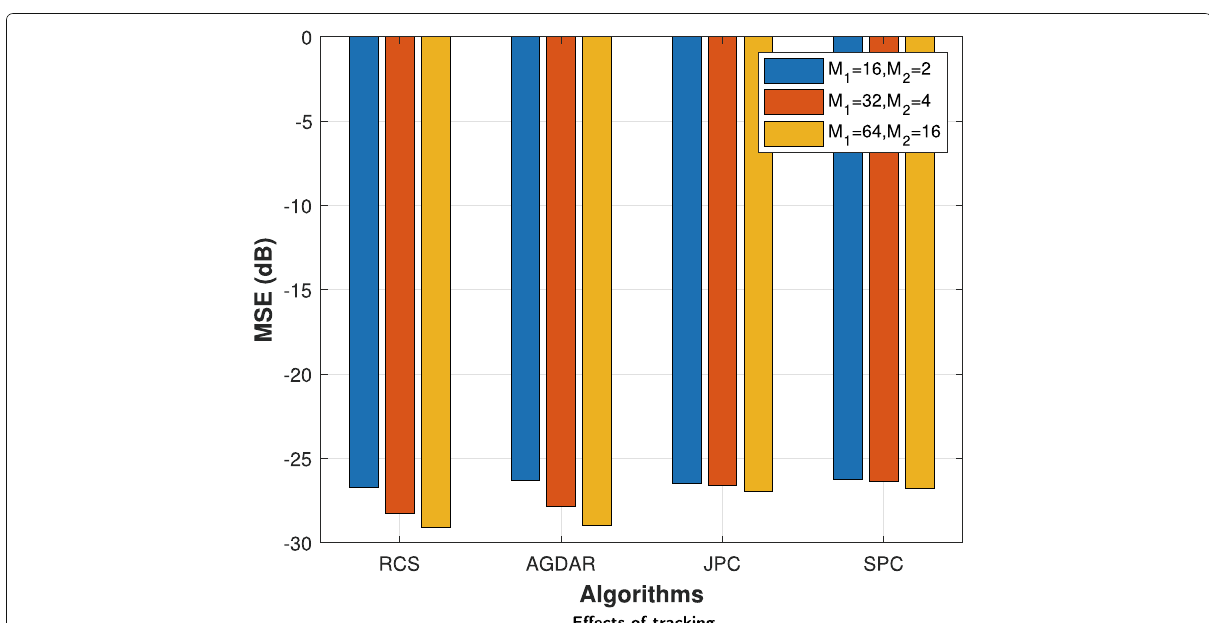
Fig. 10 Effects of tracking. MSE for ULAs of various channel estimation techniques, when the average SNR is 10 dB with channel tracking at 6 ◦ , and various values of M . N r = 16 and N t = 4